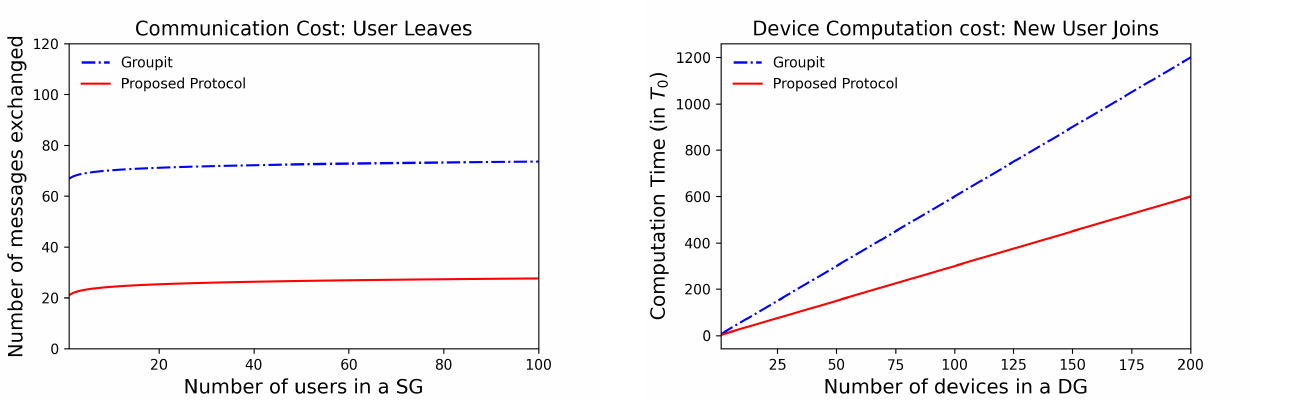
Figure 11. The figure shows the communication costs under GroupIt and the proposed protocol versus the number of users in group SG x for the case when a user leaves group SG x .